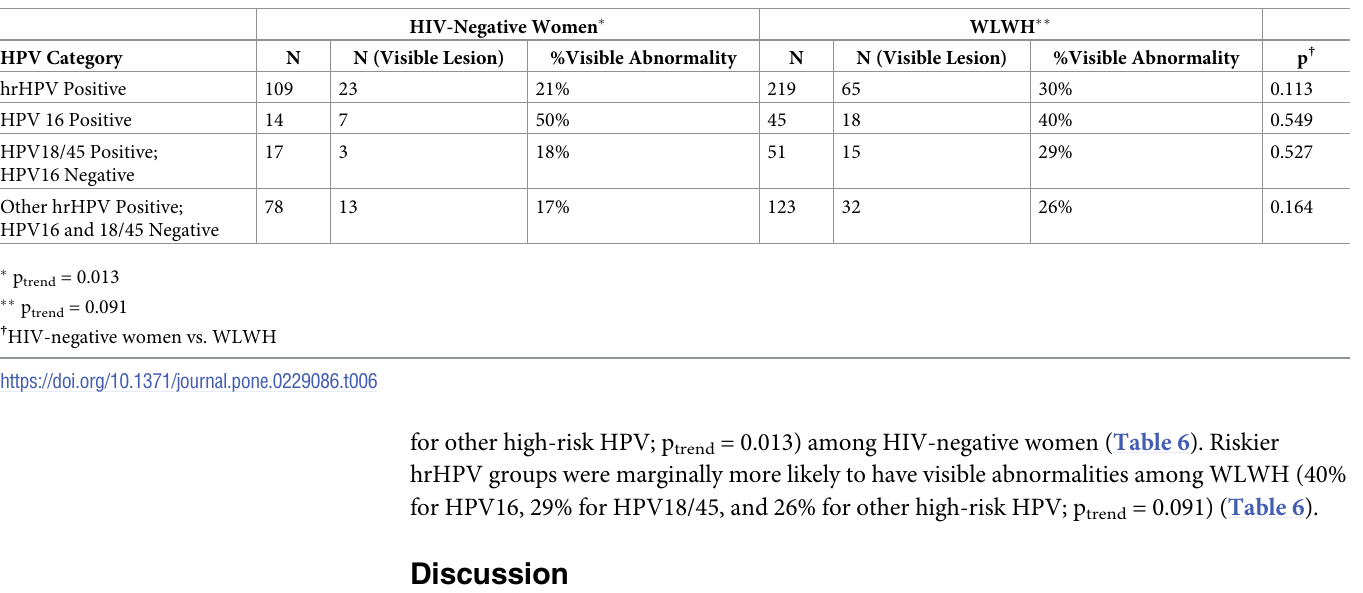
Table 6. The relationship of high-risk human papillomavirus (hrHPV) and hrHPV risk groups and the presence of visible (acetowhite) cervical abnormalities, strat- ified on HIV